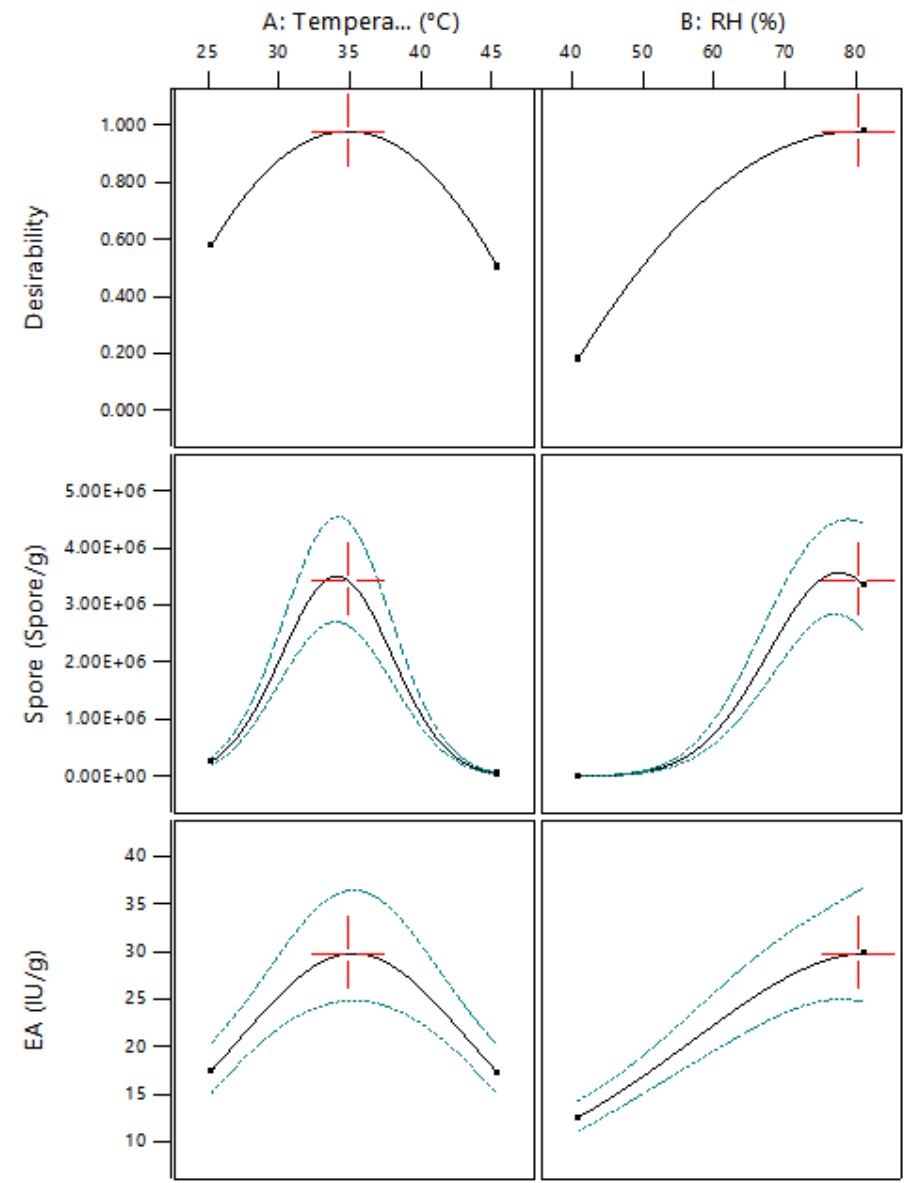
Figure 4. Graphics of a single suggested value of the desirability function for the simultaneous maximization of enzyme activity (importance of 5) and spore count (importance of 3) per gws.